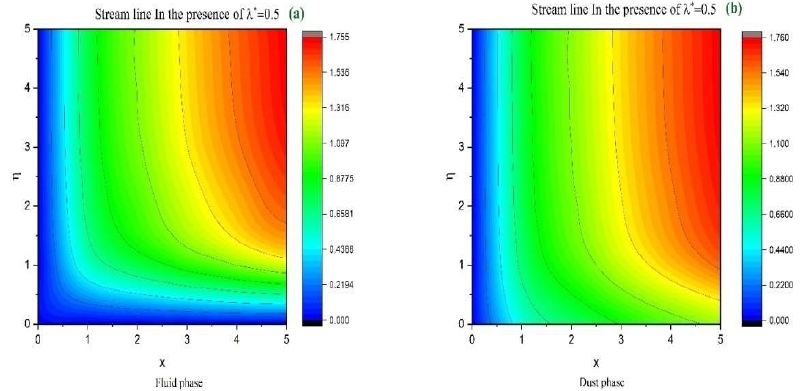
Figure 10. Streamline representation for ( a ) the fluid phase and ( b ) the dust phase in the presence of λ ∗ .